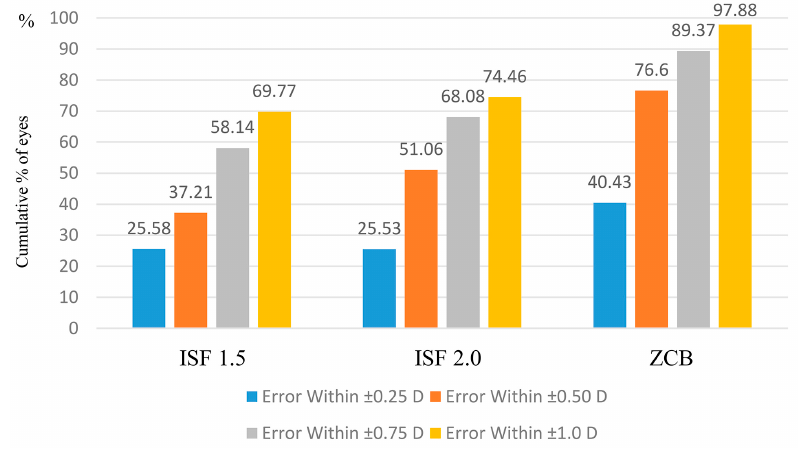
Figure 2. Cumulative refraction error by fixed position. Regarding the cumulative postoperative re- fractive error within ± 1.0 D, according to the post-op MRSE—predicted MRSE, a high result of 97.88% was calculated for the ZCB group, whereas the result was 69.77% for the ISF 1.5 group and 74.46% for the ISF 2.0 group. ISF: intrascleral fixation and MRSE: manifest refraction spherical equivalent. Table 2. Background of the iris capture Iris capture occurred in 7 of the 100 eyes in the ISF group (incidence rate: 7%). It occurred in four eyes (all male) in the ISF 1.5 group (incidence rate: 8.89%) and in three eyes (male: 2 eyes, female: 1 eye) in the ISF 2.0 group (incidence rate: 5.45%). The iris cap- ture did not occur in any of the eyes in the ZCB group (incidence: 0%; Table 2). No signif- icant differences were observed between the ISF 1.5 and ISF 2.0 groups with regard to the